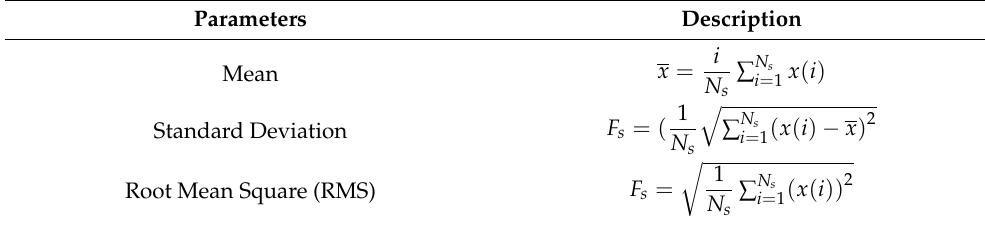
Table 3. Time-domain features mathematical representation.